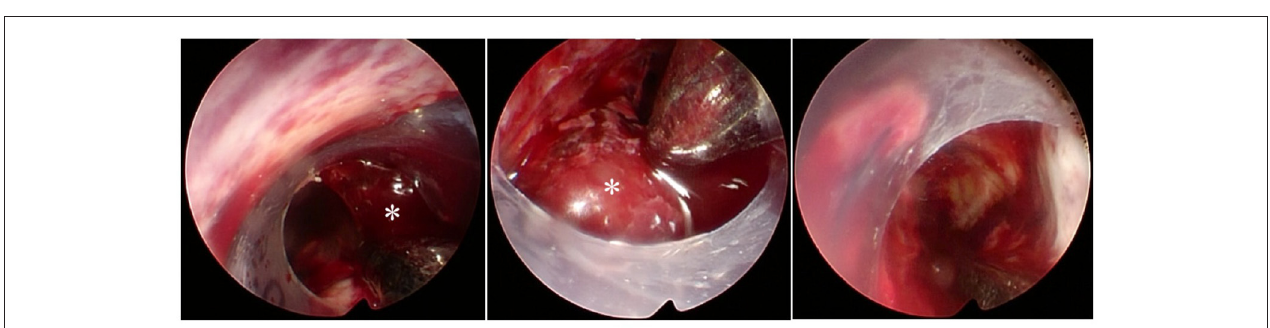
FIGURE 2 | Endoscopic view through a transparent sheath inserting to the hematoma cavity. *Hard clot difficult to suction.